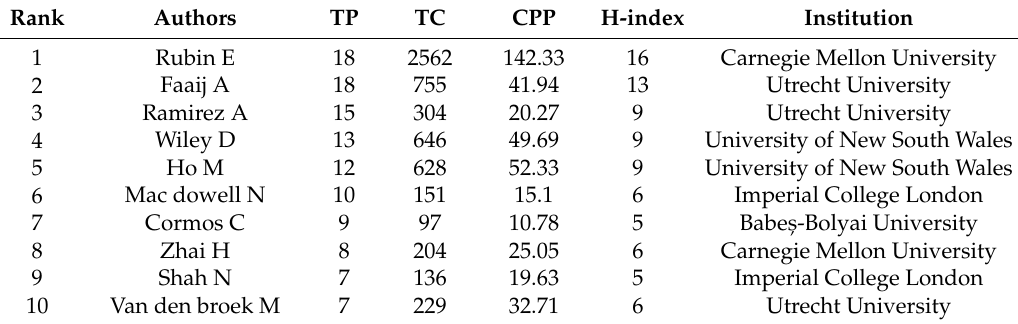
Table 4. High-yield